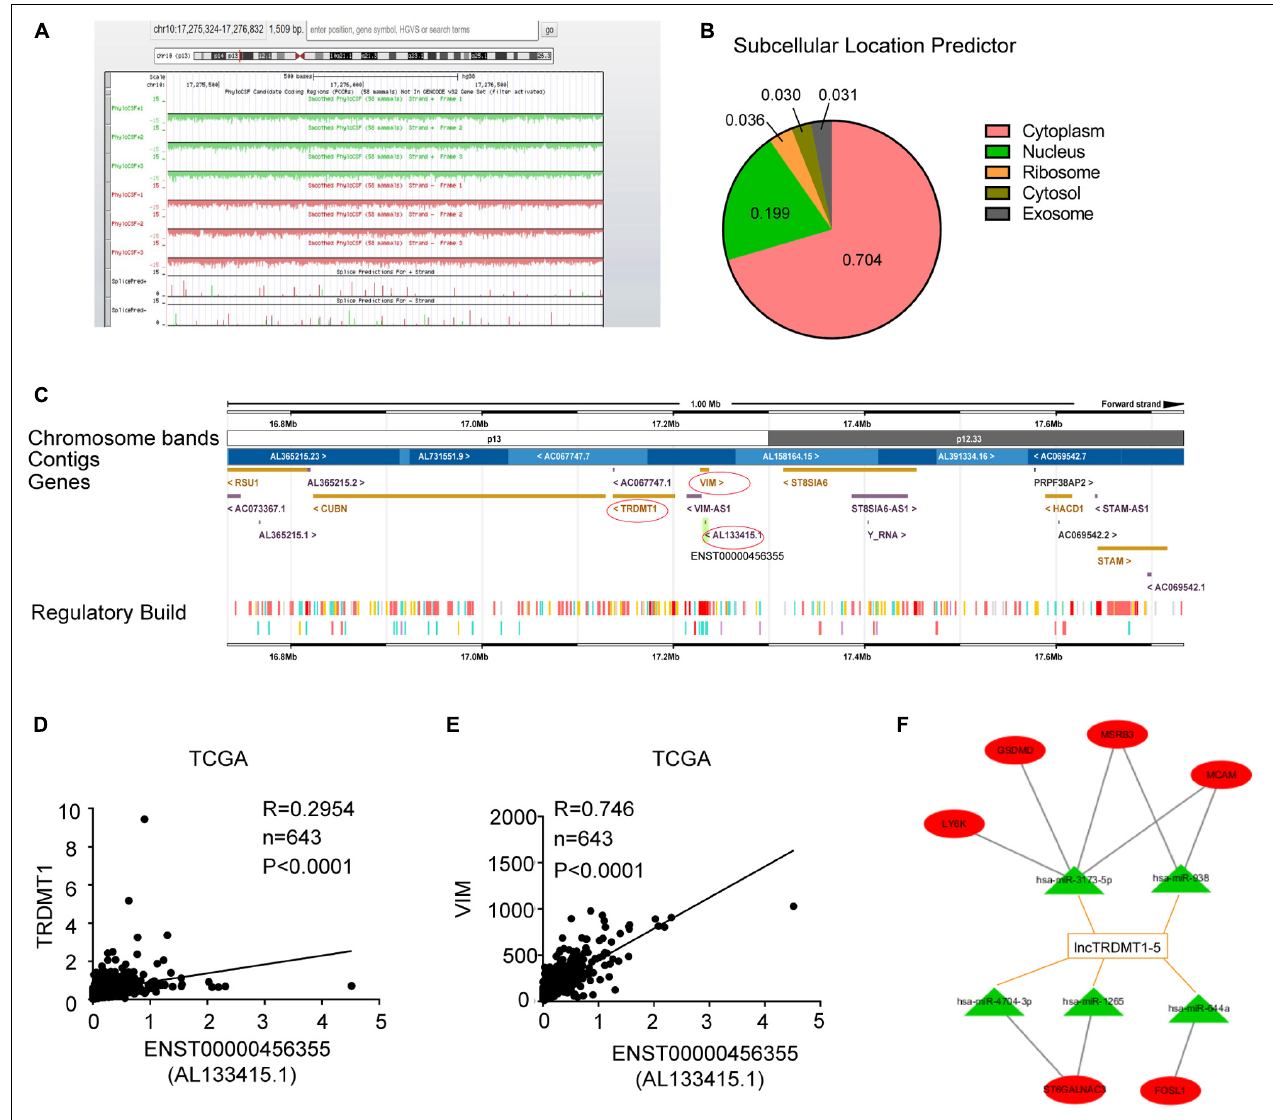
FIGURE 6 | Subcellular location and functional ceRNA network prediction for lnc-TRDMT1-5. (A) Schematic annotation of the lnc-TRDMT1-5 genomic locus on chromosome 10q17,275,324-17,276,832 in humans. Coding potency was analyzed using PhyloCSF. Scores above zero suggest coding potential, whereas scores below zero represent non-coding potential. (B) The pie chart shows the subcellular location scores of lnc-TRDMT1-5 using a subcellular location predictor (lncLocator) (http://www.csbio.sjtu.edu.cn/bioinf/lncLocator/) according to the sequence analysis. (C) The region of ENST0000456355 (AL133415.1) was identified in detail by the Ensembl database (http://asia.ensembl.org), and it shows that the protein coding gene VIM shared part of the location site with AL133415.1. Another coding gene, TRDMT1, was upstream of AL133415.1. (D) A correlation analysis between lnc-TRDMT1-5 and TRDMT1 in the TCGA database was performed on 590 invasive BC and 53 normal breast tissues. (E) The correlation analysis between lnc-TRDMT1-5 and VIM was performed on 590 invasive BC and 53 normal breast tissues. (F) A correlation network comprising lnc-TRDMT1-5-miRNA-mRNA. Correlation between lncTRDMT1-5 and miRNAs were screened for the criteria of correlation scores > 0.9, and binding scores > 0.04. Correlations between selected miRNAs and mRNAs were calculated and identified by using the TargetScan database. A total of five miRNAs and six mRNAs were selected with connecting edges using Cytoscape